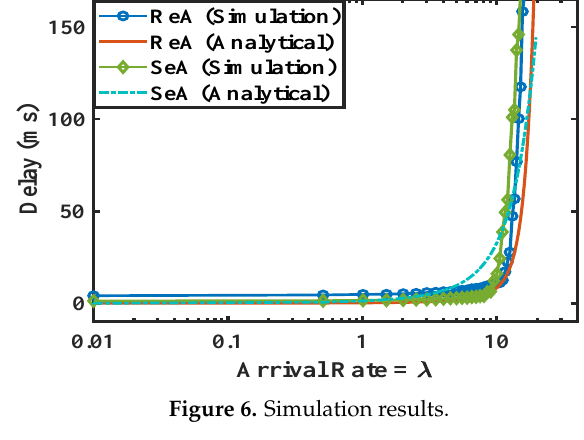
Figure 6. Simulation results.